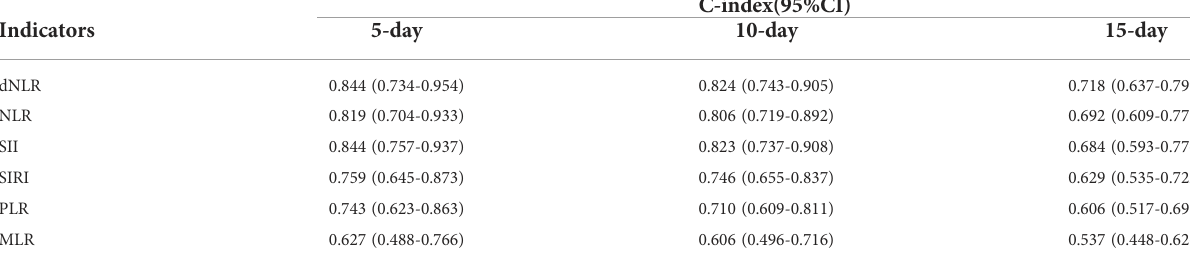
TABLE 3 C-index of six indicators for OS in COVID-19 Omicron BA.2 infected